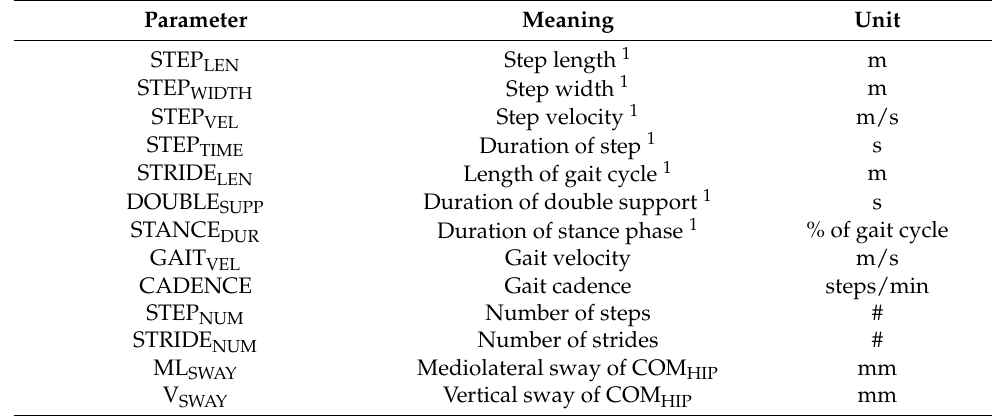
Table 2. Spatiotemporal and COM HIP parameters related to gait